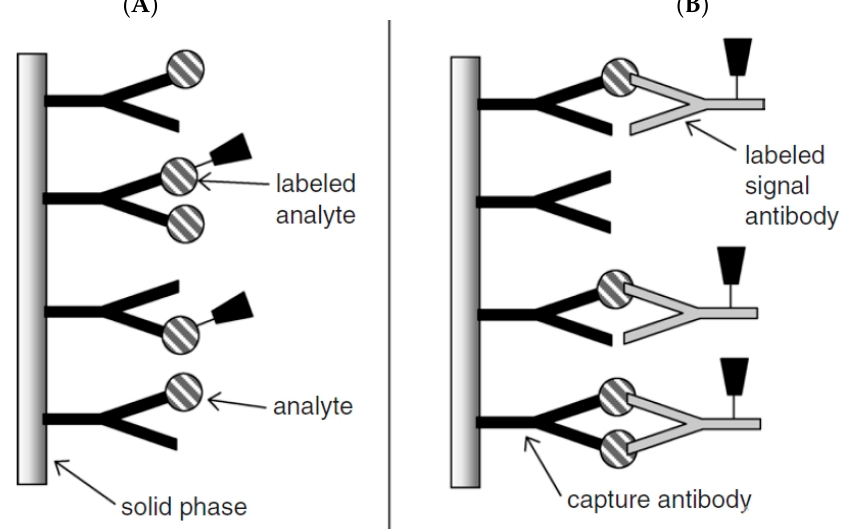
Figure 2. Schematic representation of ( A ) competitive and ( B ) non-competitive immunoassay formats. Reprinted with Permission [35].